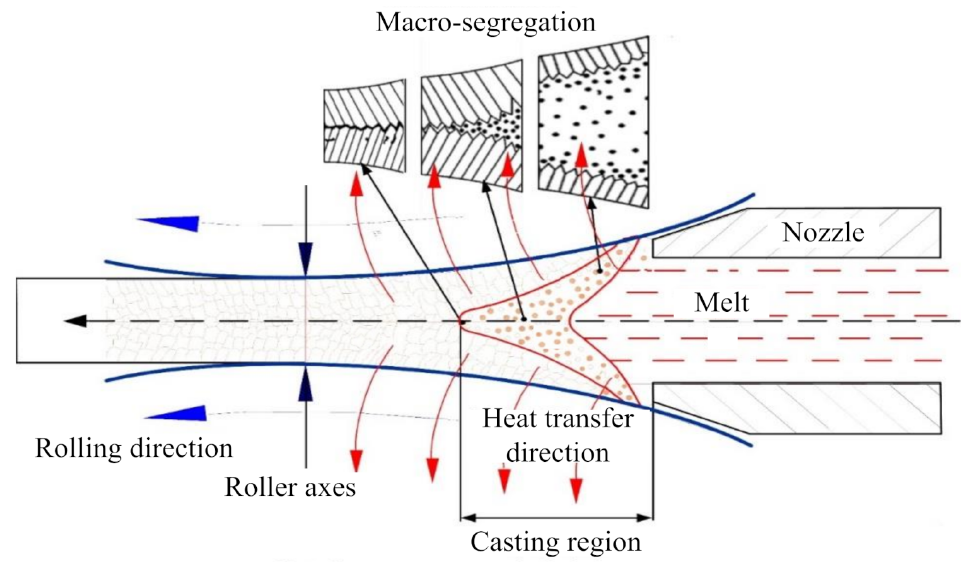
Figure 8. Generation mechanism of the central macro-segregation in TRC